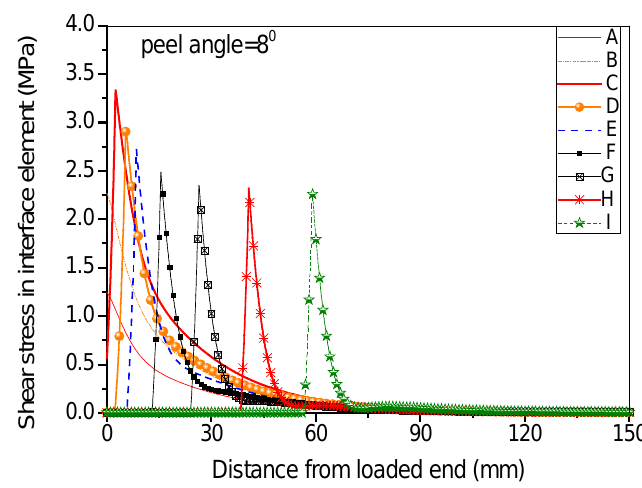
Figure 22. Shear stress distribution along the interface at different load levels when the peel angle = 8 degree.